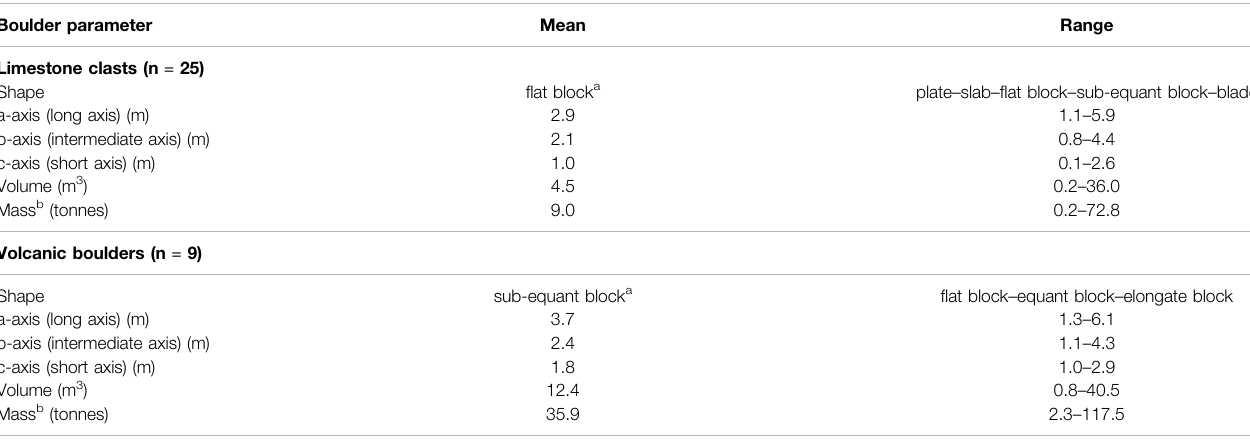
TABLE 2 | Summary measurements of coastal boulders on Dahu Reef, southeast Ludao. Boulder